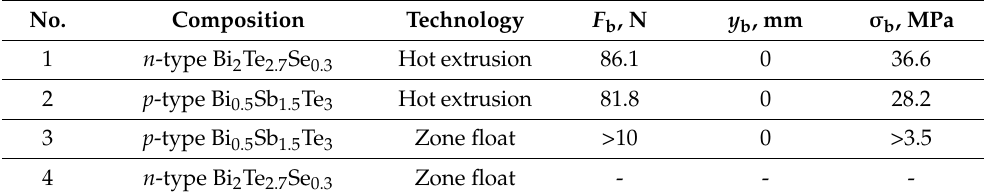
Table 1. Bending strength σ b and deflection y b of Bi 2 Te 3 -based compound specimens prepared with different technologies.